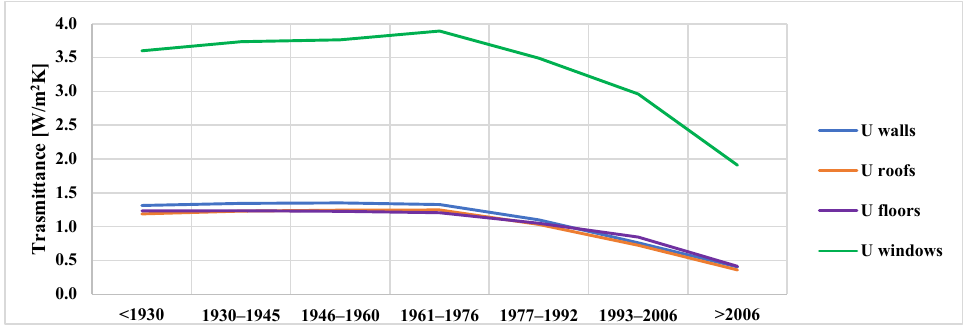
Figure 2. Trend in average thermal transmittance by walls, floors, roofs and windows of the average flat in Milan, by age of construction.